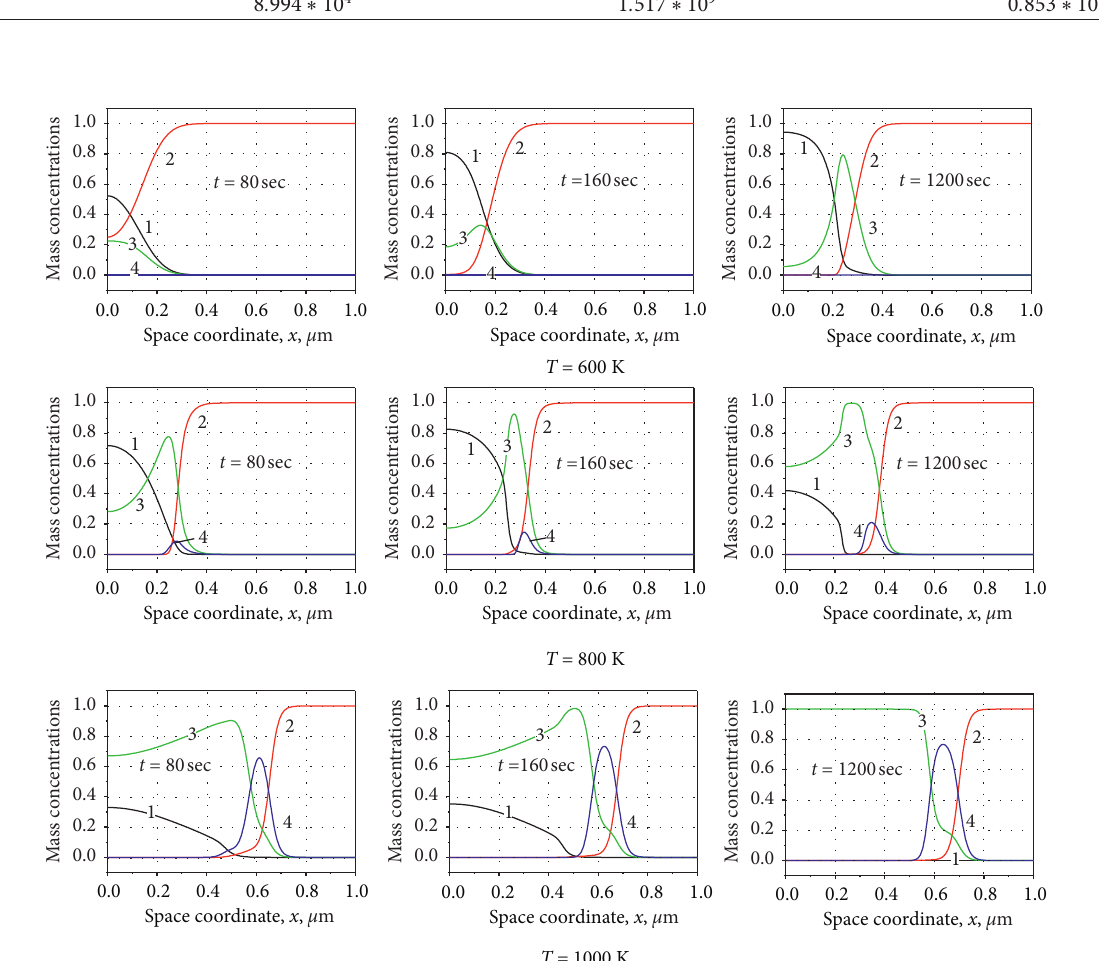
Figure 1: The distribution of phases and elements at various times and at various temperatures are given for the slow process, � 0 . 3 ( mol/ μ m 3 s ) ; t � 400sec. q m imp